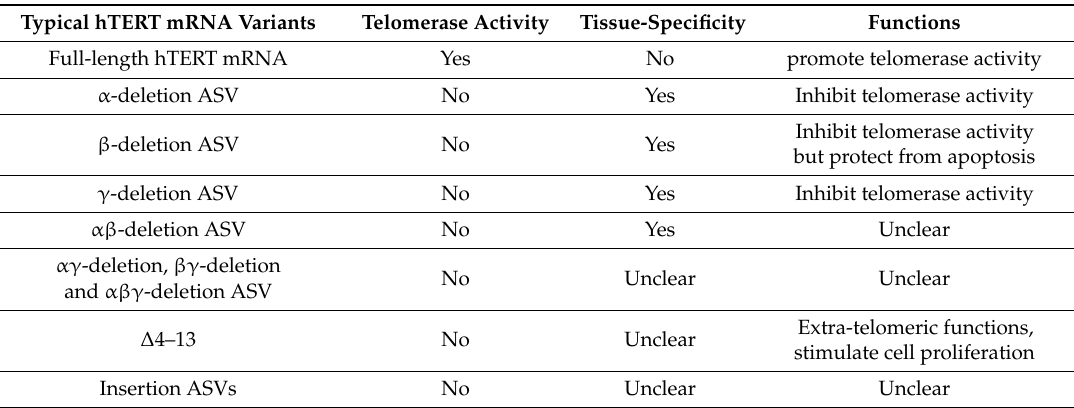
Table 1. Information of hTERT mRNA alternative splicing